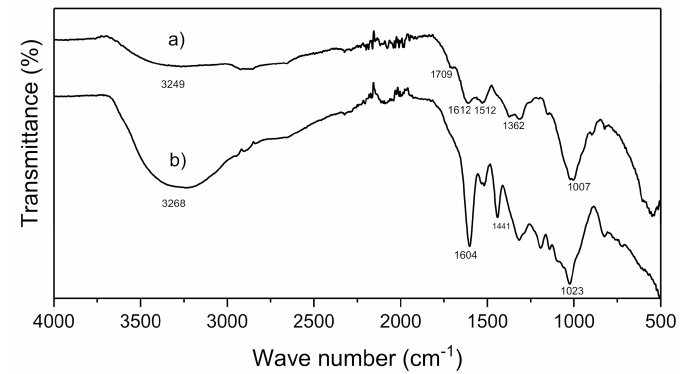
Figure 5. FT-IR of ( a ) silver nanoparticles and ( b ) pecan nut sell